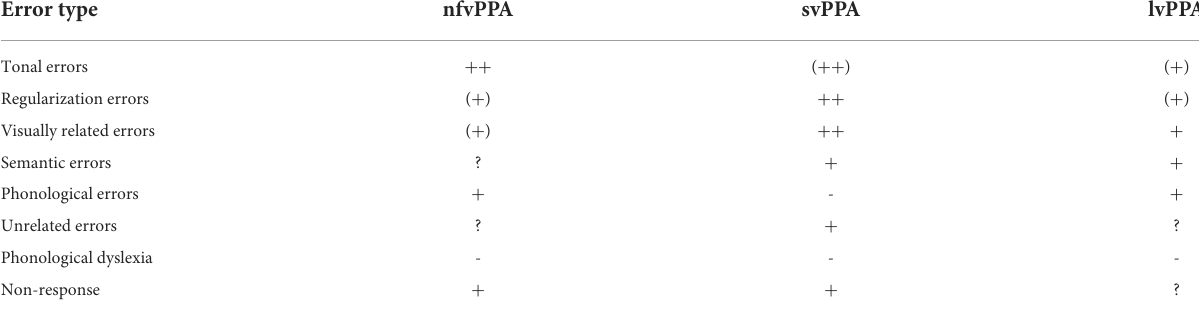
TABLE 3 Types of reading errors of patients with PPA variants.